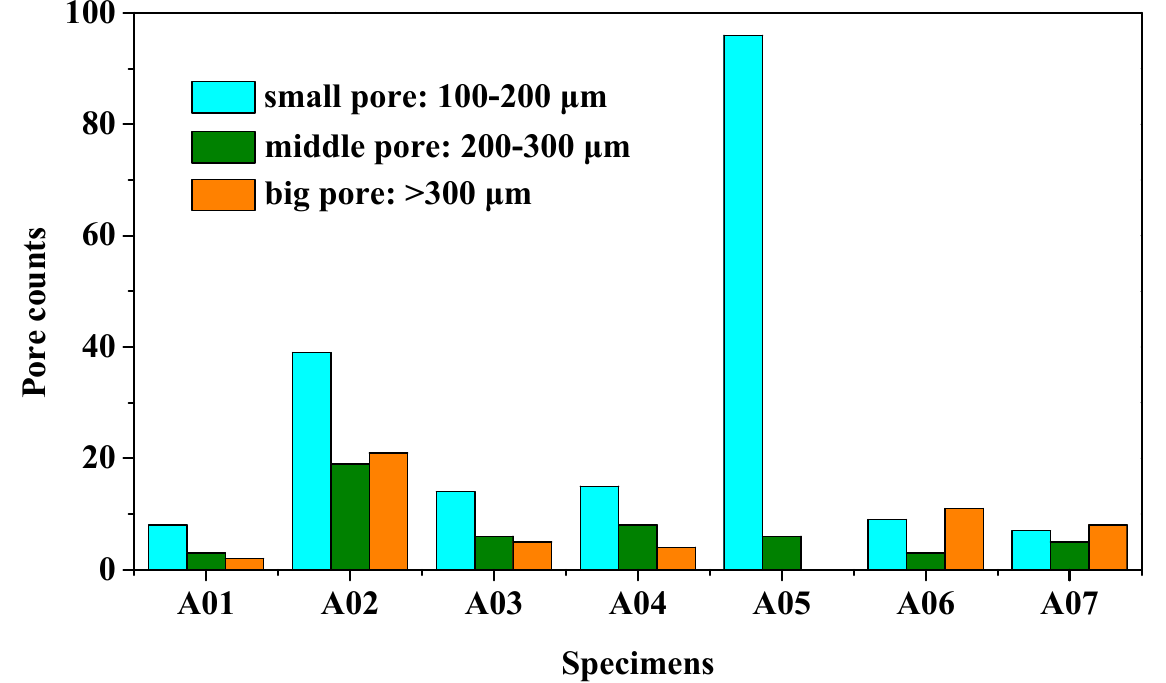
Figure 6. The pore distribution in the center of specimens A01–A07.